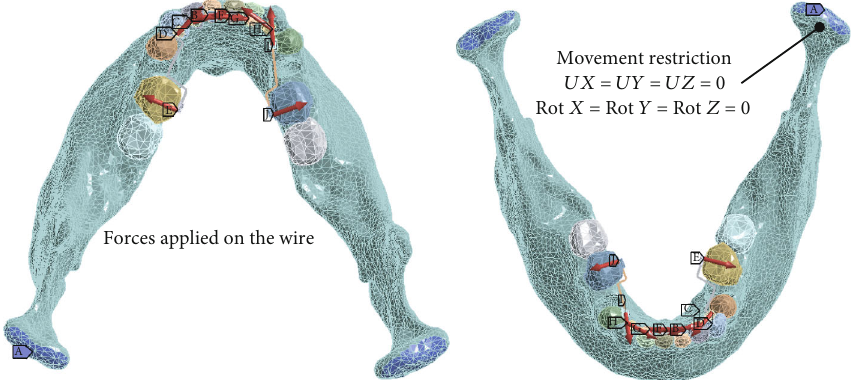
Figure 9: Boundary conditions and forces applied to the wire according to their actual application to brackets and teeth. The red arrows indicate the direction of the forces generated in the wire, in each dental organ.